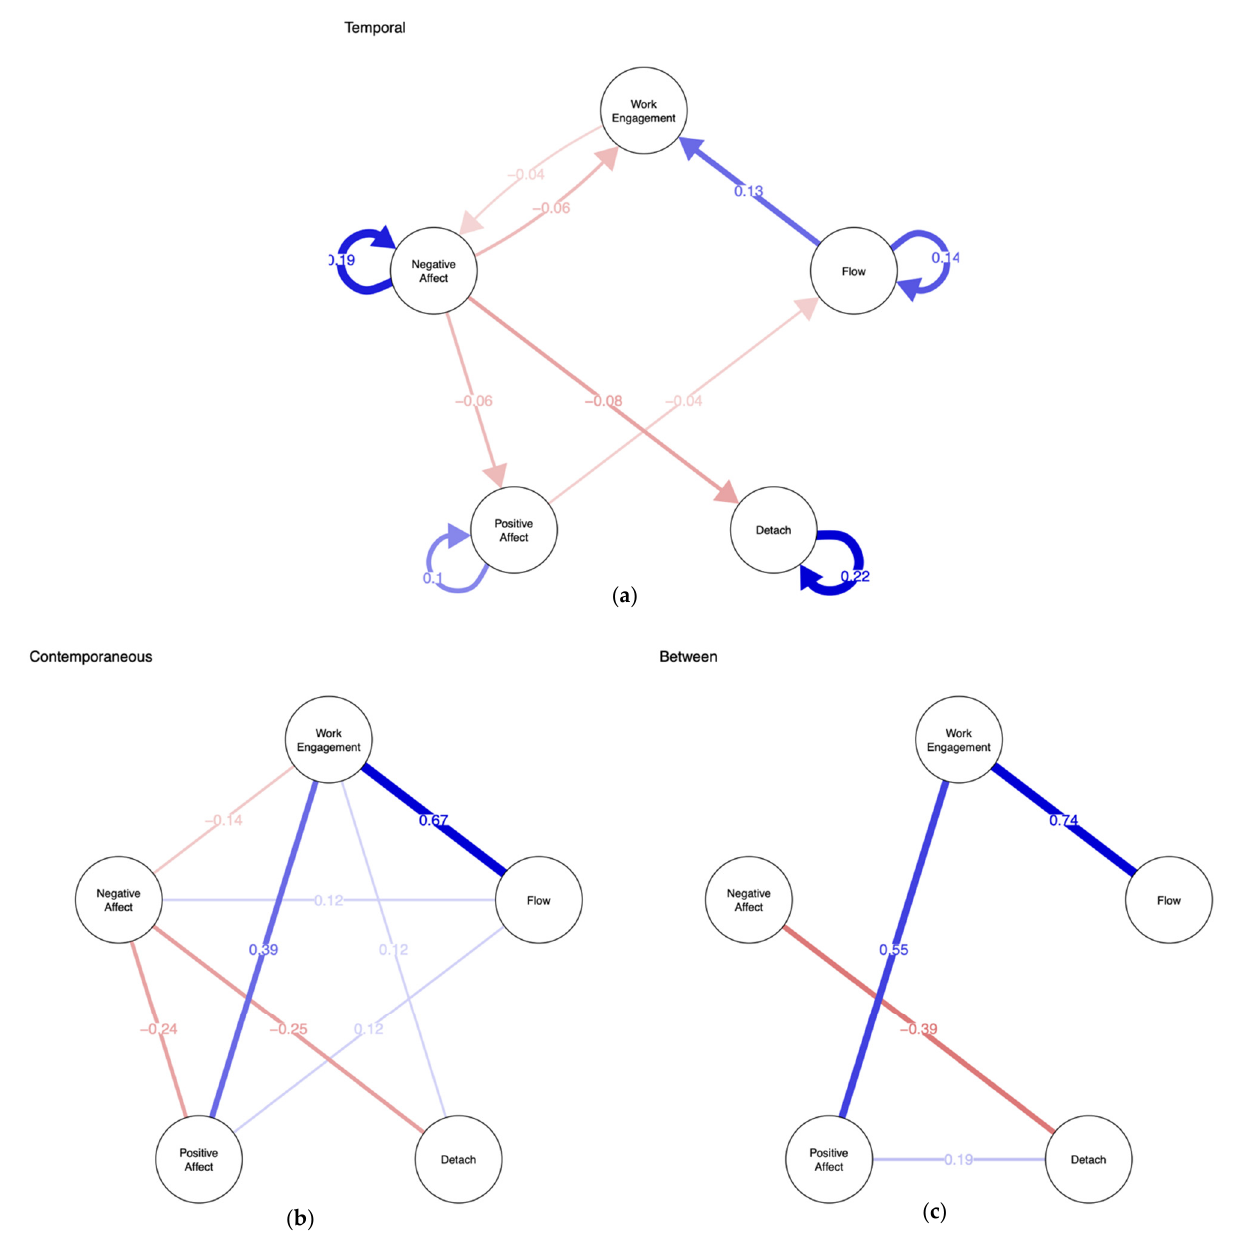
Figure 2. Results of the temporal network analysis of the daily variables work engagement, flow, detachment from work, positive affect and negative affect. Blue lines represent positive associations; red lines negative associations. ( a ) The estimated temporal network, standardized to partial directed correlations, and the edges with arrow indicate how one variable on day n predicts the other on day n + 1; ( b ) the estimated contemporaneous partial correlation network, and the edges indicate association between two variables on the same day; ( c ) the estimated between-subjects partial correlation network, and the edges indicate cross-subject association among the daily variables.